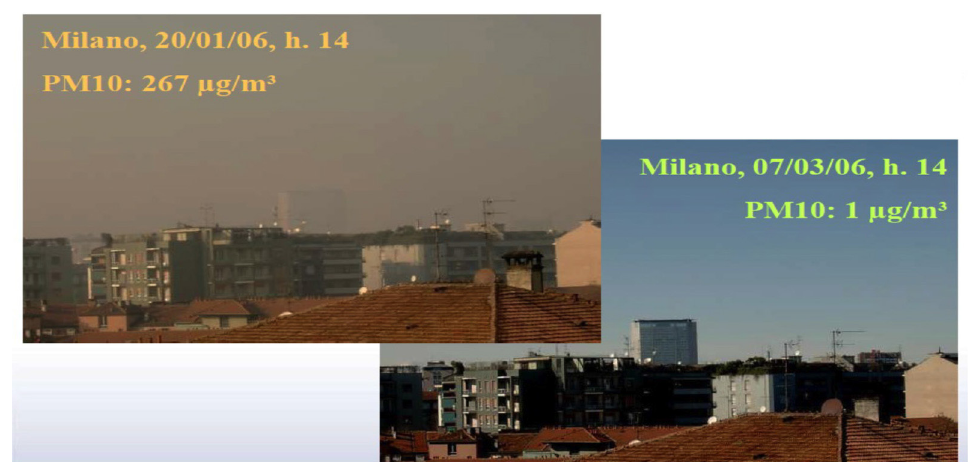
Fig. 9. – Visibility in Milan from the same observation point in days with different PM10 atmospheric concentrations. (Courtesy of Dr. Lazzarini, ARPA Lombardia.)